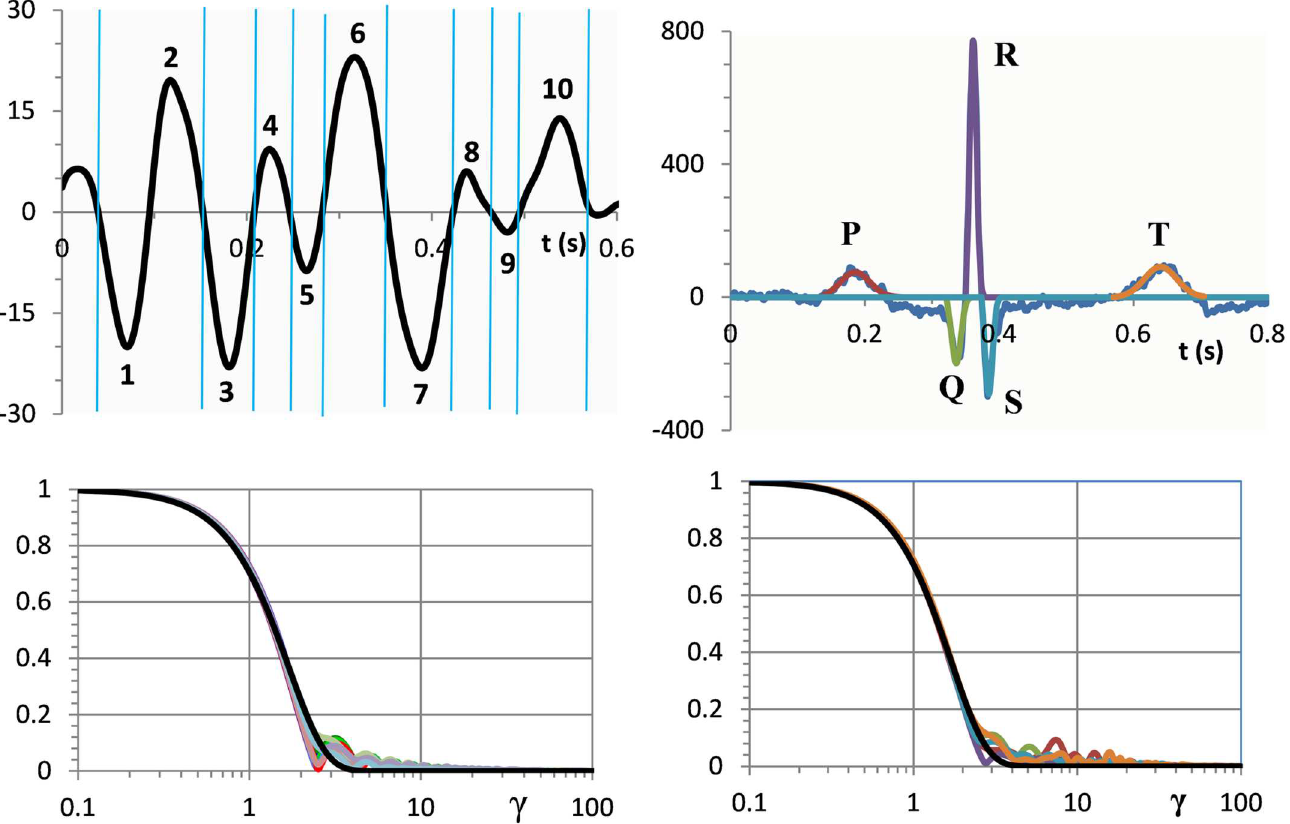
Fig 3. Upper panel: EEG (on the left side) and ECG (on the right side) records selected for the time-frequency analysis (the y-axis units are μ V). 10 half-waves selected for EEG analysis represent signal fragments between segmentation points indicated by vertical lines. 5 selected ECG half-waves correspond to the waveforms of P, Q, R, S and T components. Lower panel: normalized amplitude spectra (coloured lines) in comparison with Gaussian curves (black lines). The y- axis units are